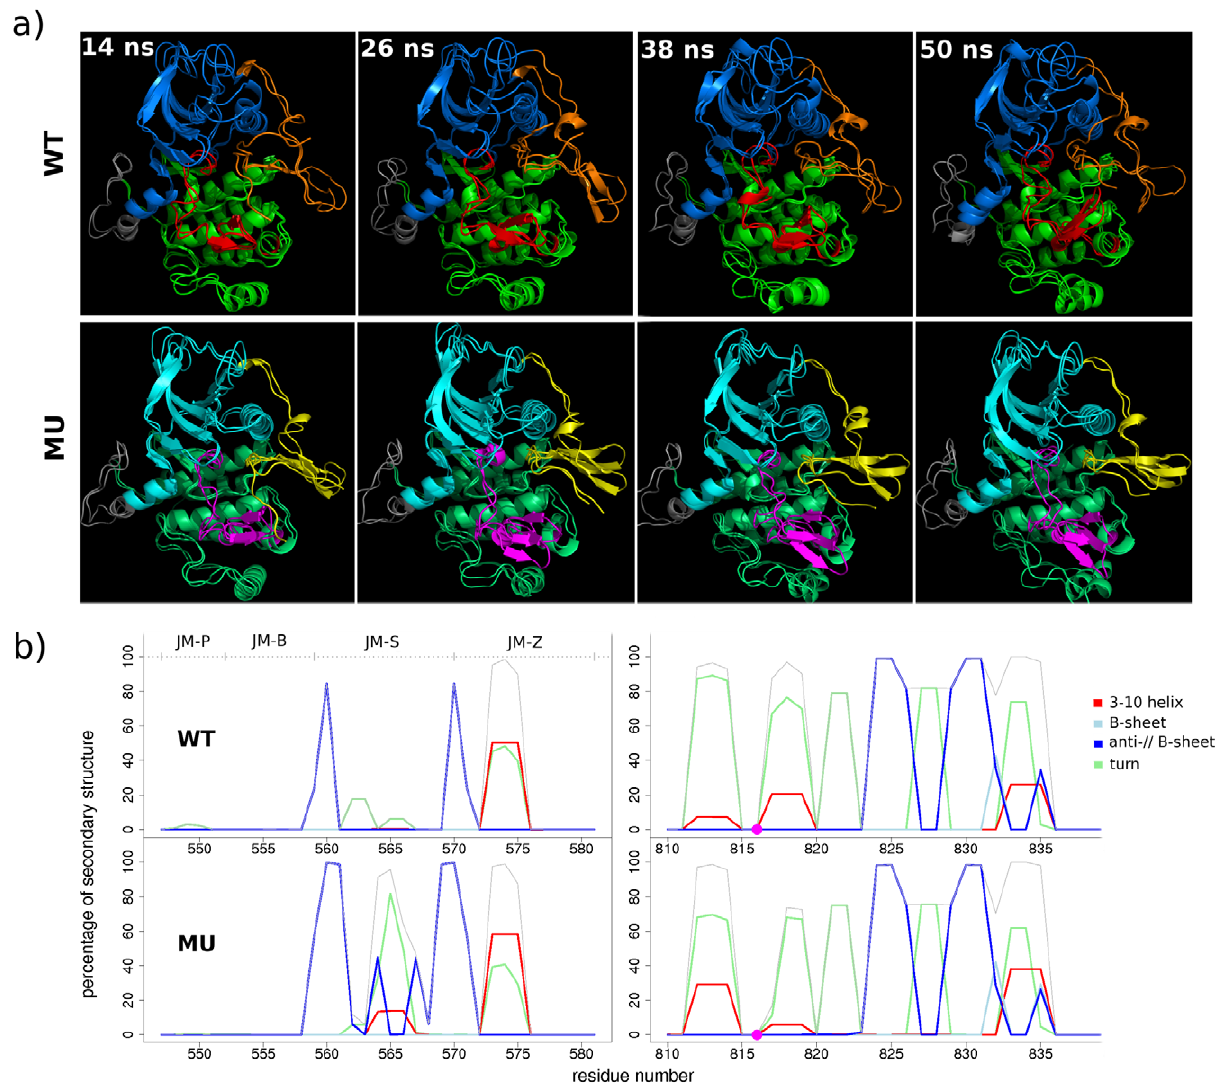
Figure 4. MD conformations and secondary structure of wild-type and D816V-mutated KIT cytoplasmic region in the inactive state. ( a ) MD conformations were taken at 14, 26, 38 and 50 ns from the two 50-ns MD simulations of wild-type KIT, WT 547-935 ( upperpanel ) and D816V mutant, MU 547-935 ( lowerpanel ) and were superimposed by pair in cartoon representation. JMR is in orange (WT) and yellow (MU), N-lobe is in green (WT) and lime (MU), A-loop is in red (WT) and magenta (MU), and C-lobe is in marine (WT) and cyan (MU). ( b ) Secondary structure assignments for JMR (on the left) and A-loop (on the right) were averaged over the two 50-ns MD simulations of wild-type KIT, WT 547-935 (at the top) and D816V mutant, MU 547-935 (at the bottom). For each residue, the proportion of every secondary structure type is given as a percentage of the 96-ns total productive simulation time. 3 10 helix is colored in red, parallel b -sheet in light blue, anti-parallel b -sheet in dark blue, turn in green and the cumulative sum in gray. The 816 position is indicated by a big point in